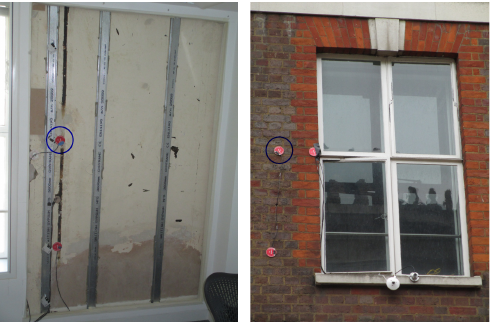
Figure 3. Internal ( left ) and external ( right ) view of the solid brick wall (SWall) case study. Circled in blue are the pair of sensors